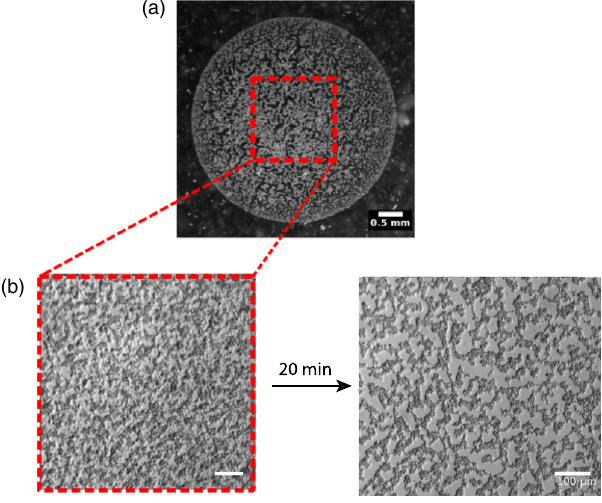
FIG. 12. Upon deposition on the highly viscous substrate fluid, yeast cells first spread uniformly in the circular inoculant region usually called the “ homeland ” [7] and then clump together via a coarsening process. (a) Distribution of cells 20 min after inoculation on the viscous substrate and (b) enlarged view immediately after inoculation (left) and after 20 min (right). The initially uniform distribution of yeast segregates into large clumps in a phase-separation process, suggestive of attractive interactions. The bottom scale bar corresponds to 100 μ